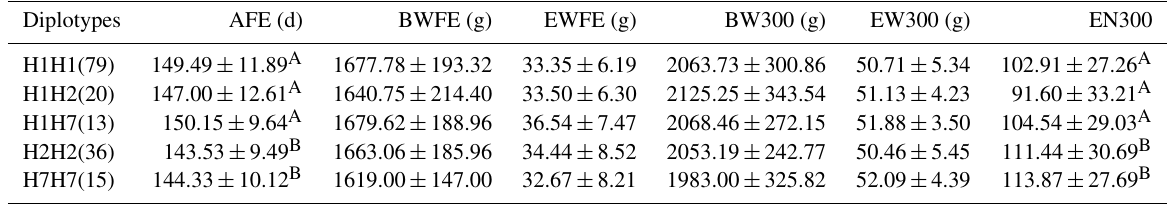
AFE represents the age at first egg, BWFE represents the body weight at first egg, EWFE represents the egg weight of first egg, BW300 represents the body weight at 300d old, EW300 represents the egg weight at 300d old and EN300 represents the egg number by 300d old. Different capital letters in the same column denote extremely significant differences ( p < 0 . 01